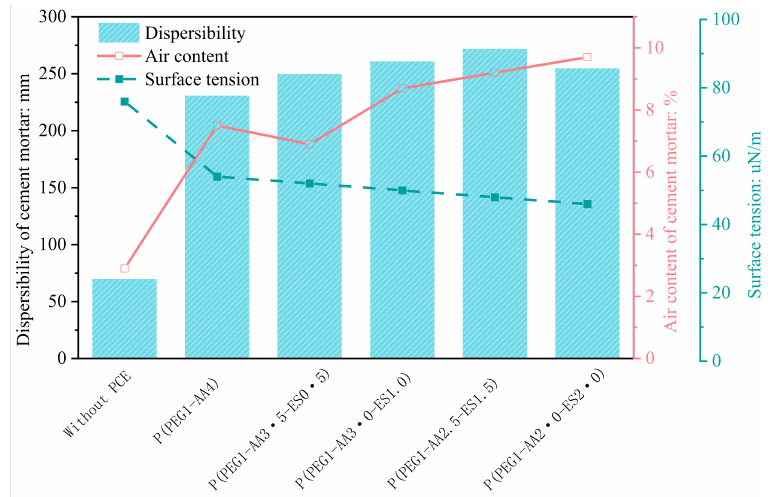
Figure 18. Effect of introducing ester groups in PCEs on the air void of fresh cement